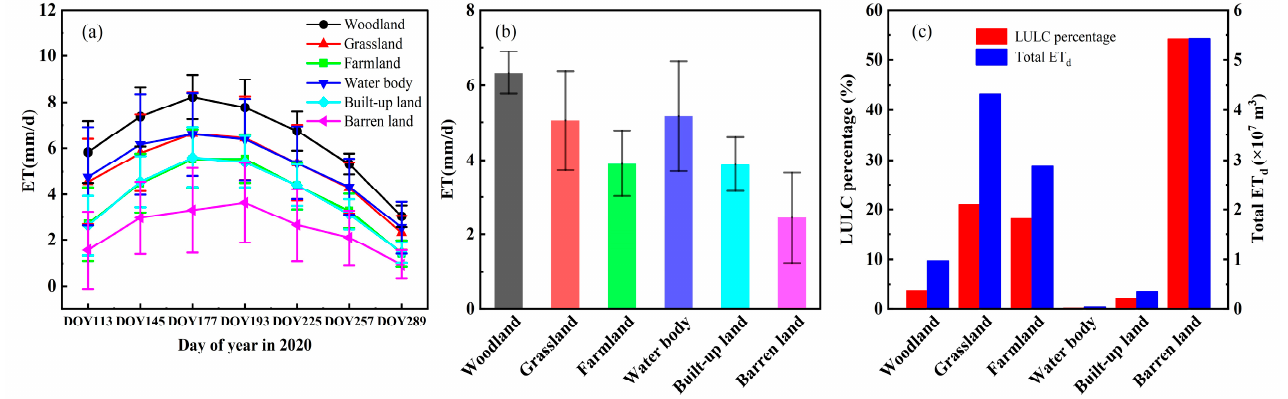
Figure 6. ( a ) Variation of ET d in the growing season under di ff erent LULC types; ( b ) average ET d of di ff erent LULC types; ( c ) total ET d and area percentage for each LULC type in the study area. Bars indicate standard deviation.